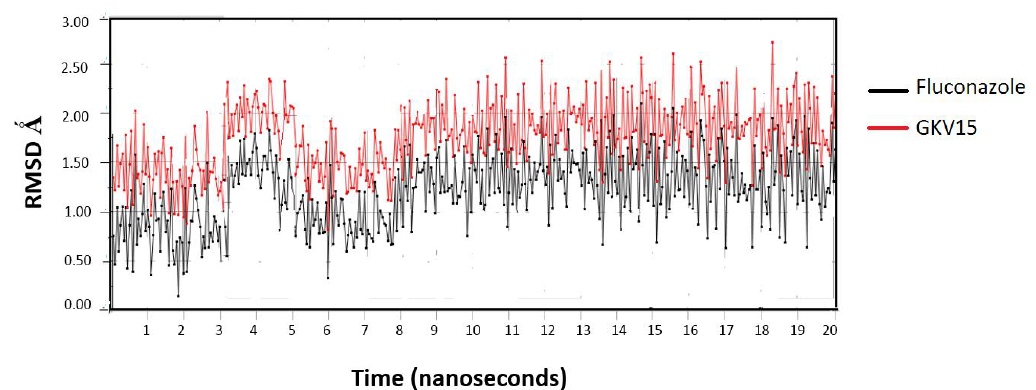
Figure 8. The molecular dynamics simulations over 20 ns.